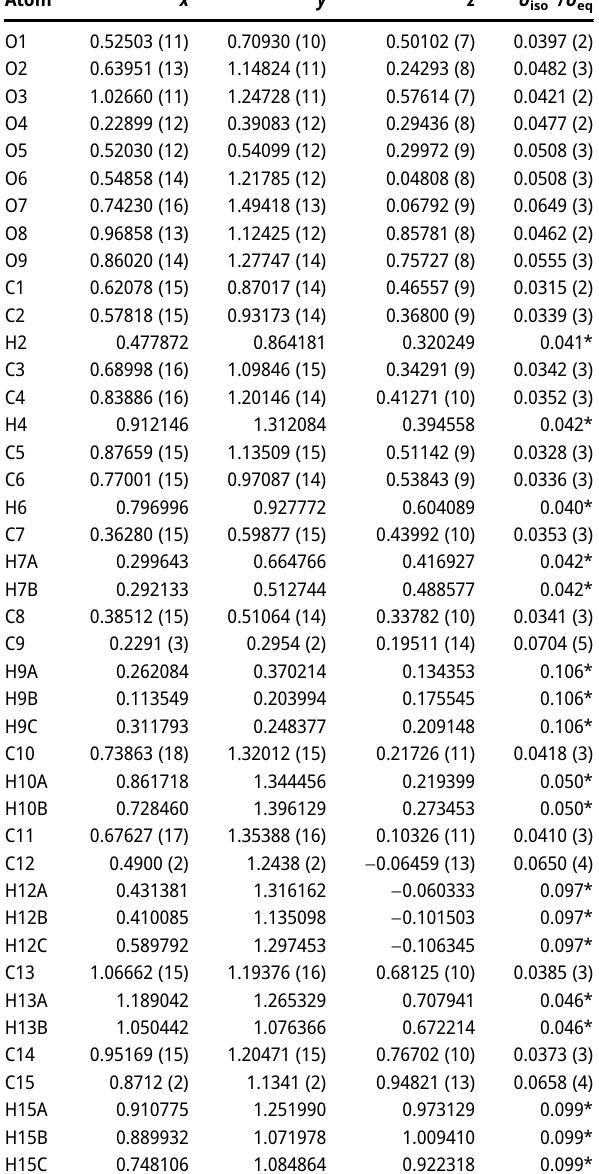
Table  : Symmetry operations and geometric characteristics of inter- molecular hydrogen